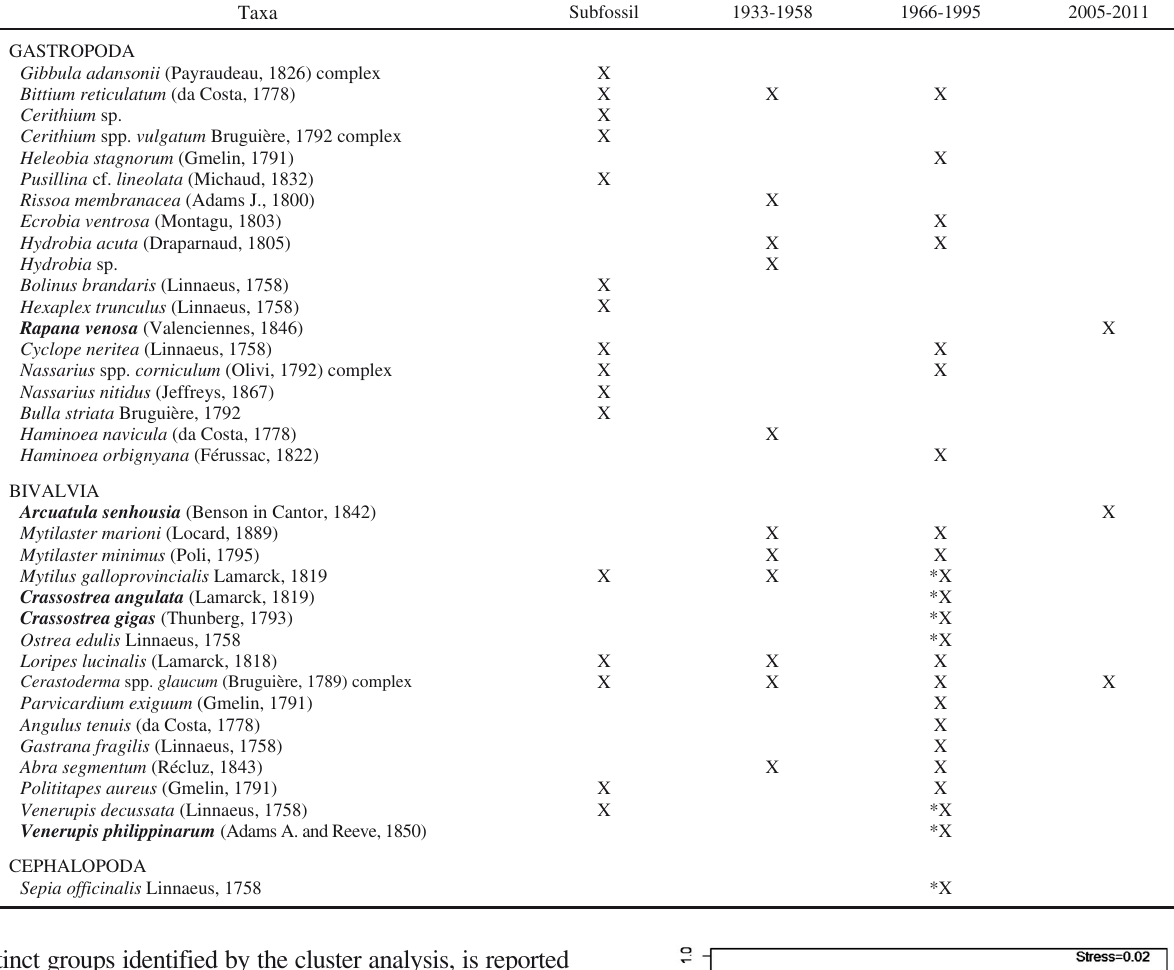
Table 2. – Records of molluscan species from the Sabaudia Lake (from the literature only). A record is marked with an asterisk (*) if a local introduction or translocation has been traced in the literature: see Appendix 1 for further details. Bold: alien species in the Italian territorial seawaters (Crocetta 2012, Crocetta et al. 2013, see Appendix 1 for discussion on C. angulata ).